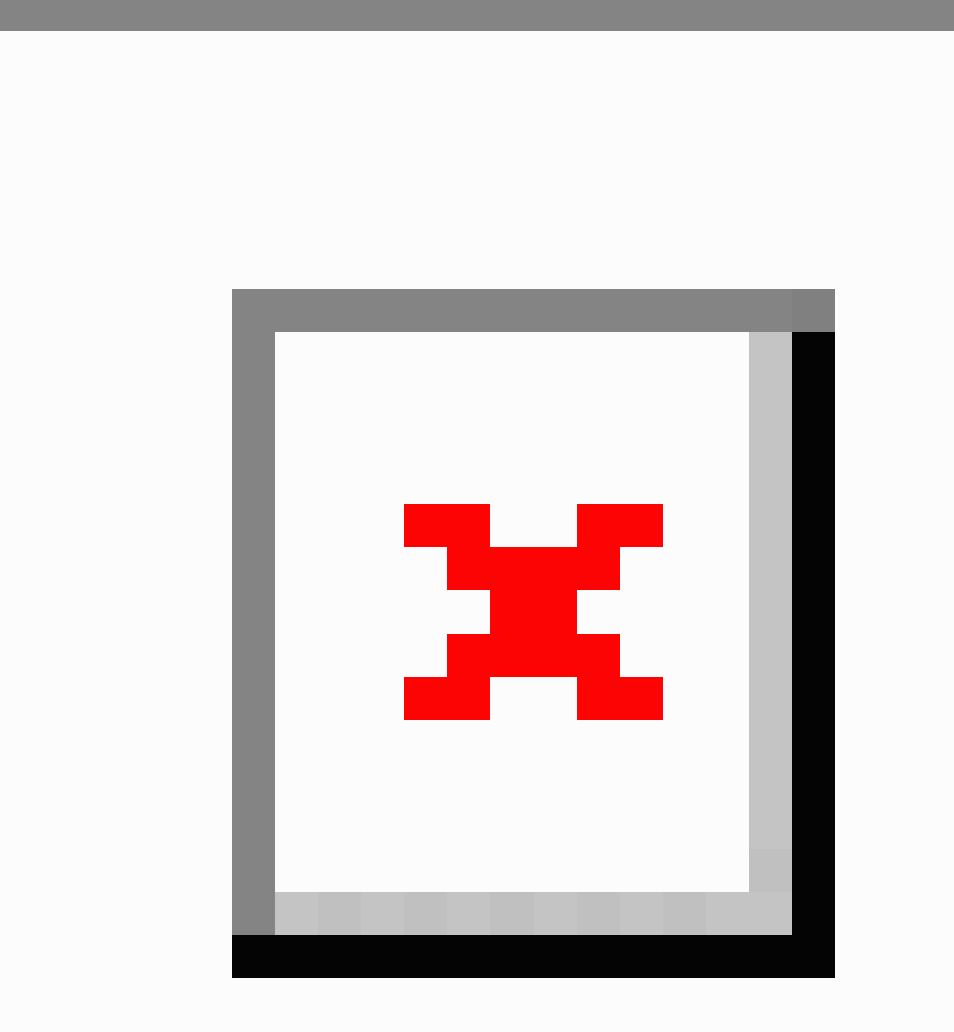
Figure 3. The authoring workflow of an interactive algorithm from choosing the topic through a review process to deployment to teaching in the form of a moderated problem-based learning